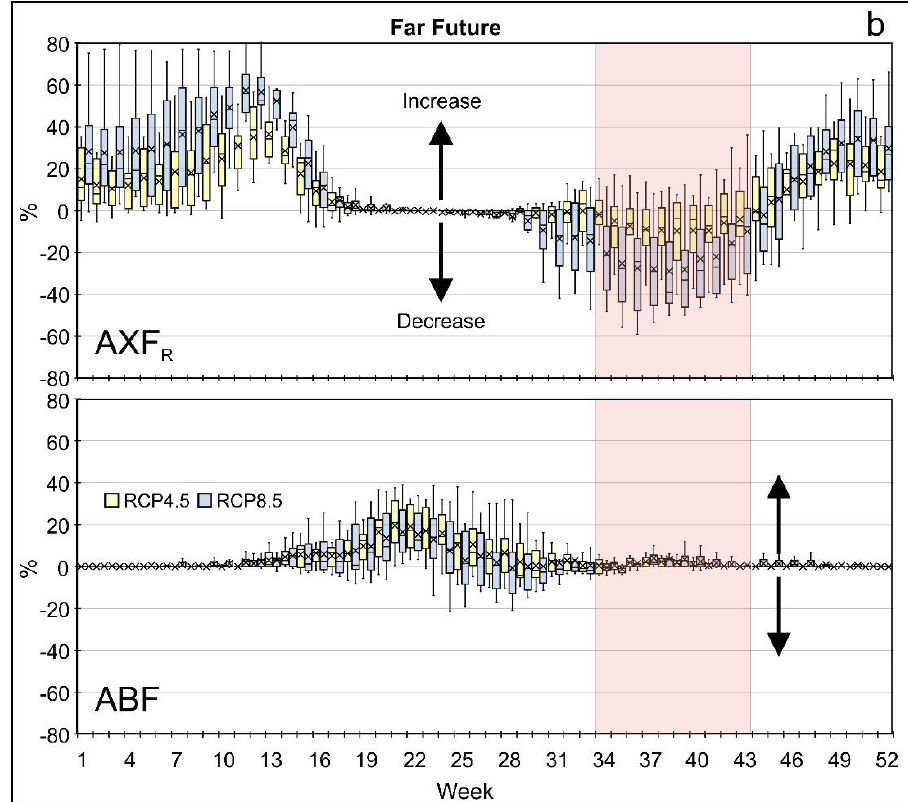
Figure 7. Simulated projected changes of the percentage over threshold (POT) occurrences for navigation thresholds 500 m 3 s −1 (POT 500 ) and 1600 m 3 s −1 (POT 1600 ) that correspond to the revised Aboriginal Extreme Flow (AXF R ) and Aboriginal Base Flow (ABF), respectively, under ( a ) near (2041–2070) and ( b ) far future (2071–2100) periods relative to the historical baseline reference (1981–2010). Flow data were derived via the variable infiltration capacity model based on 12 sets of climate projections (6 global circulation models × 2 statistically downscaled models) and 2 representative concentration pathways (RCPs 4.5 and 8.5). The fall navigability period is highlighted in red.